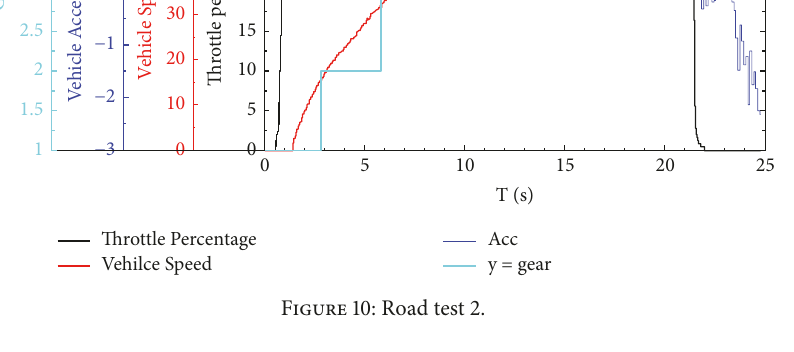
Figure 10: Road test 2.